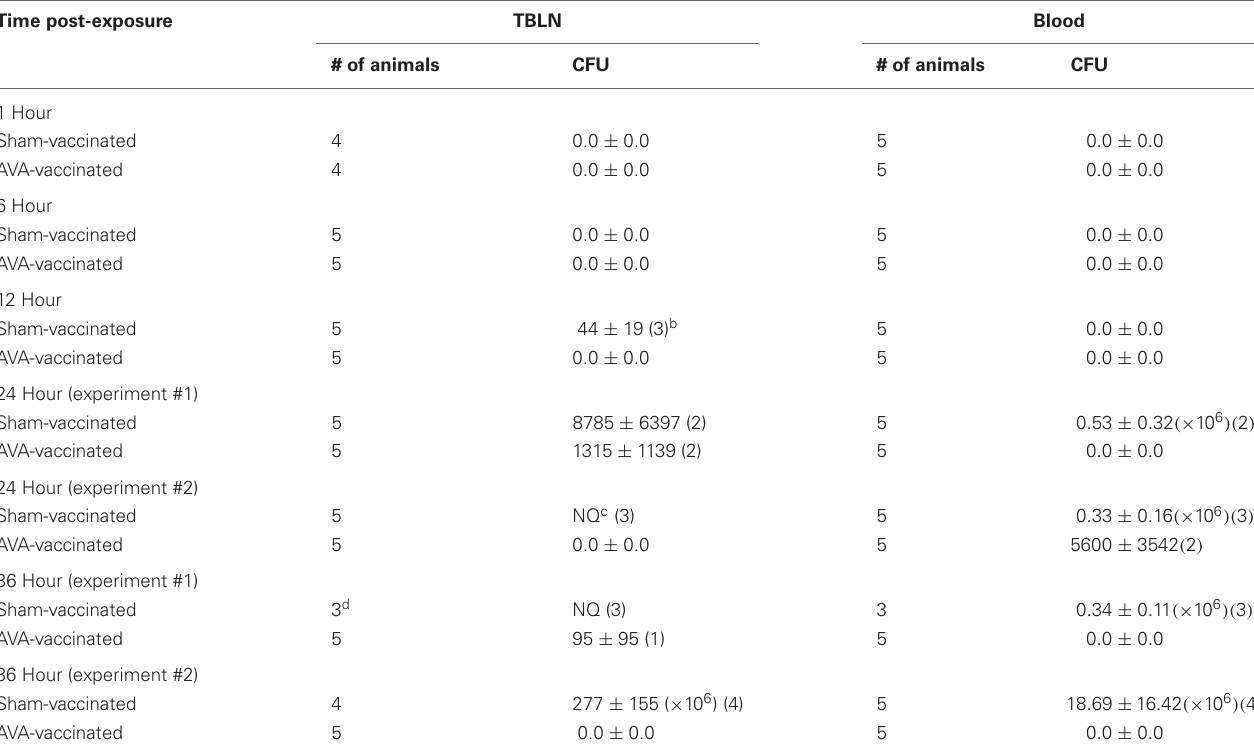
Table 4 | Total bacteria in the tracheobronchial lymph nodes (TBLN) and blood a . Time post-exposure